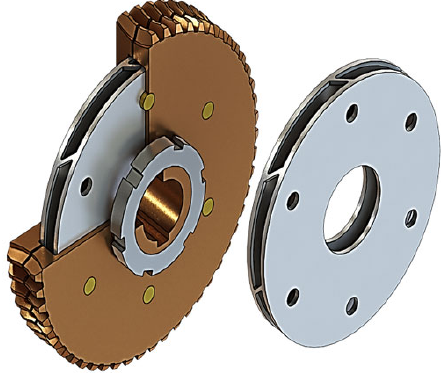
Figure 11. Worm gear drive with worm wheel rim positioned on a thin-walled sleeve.